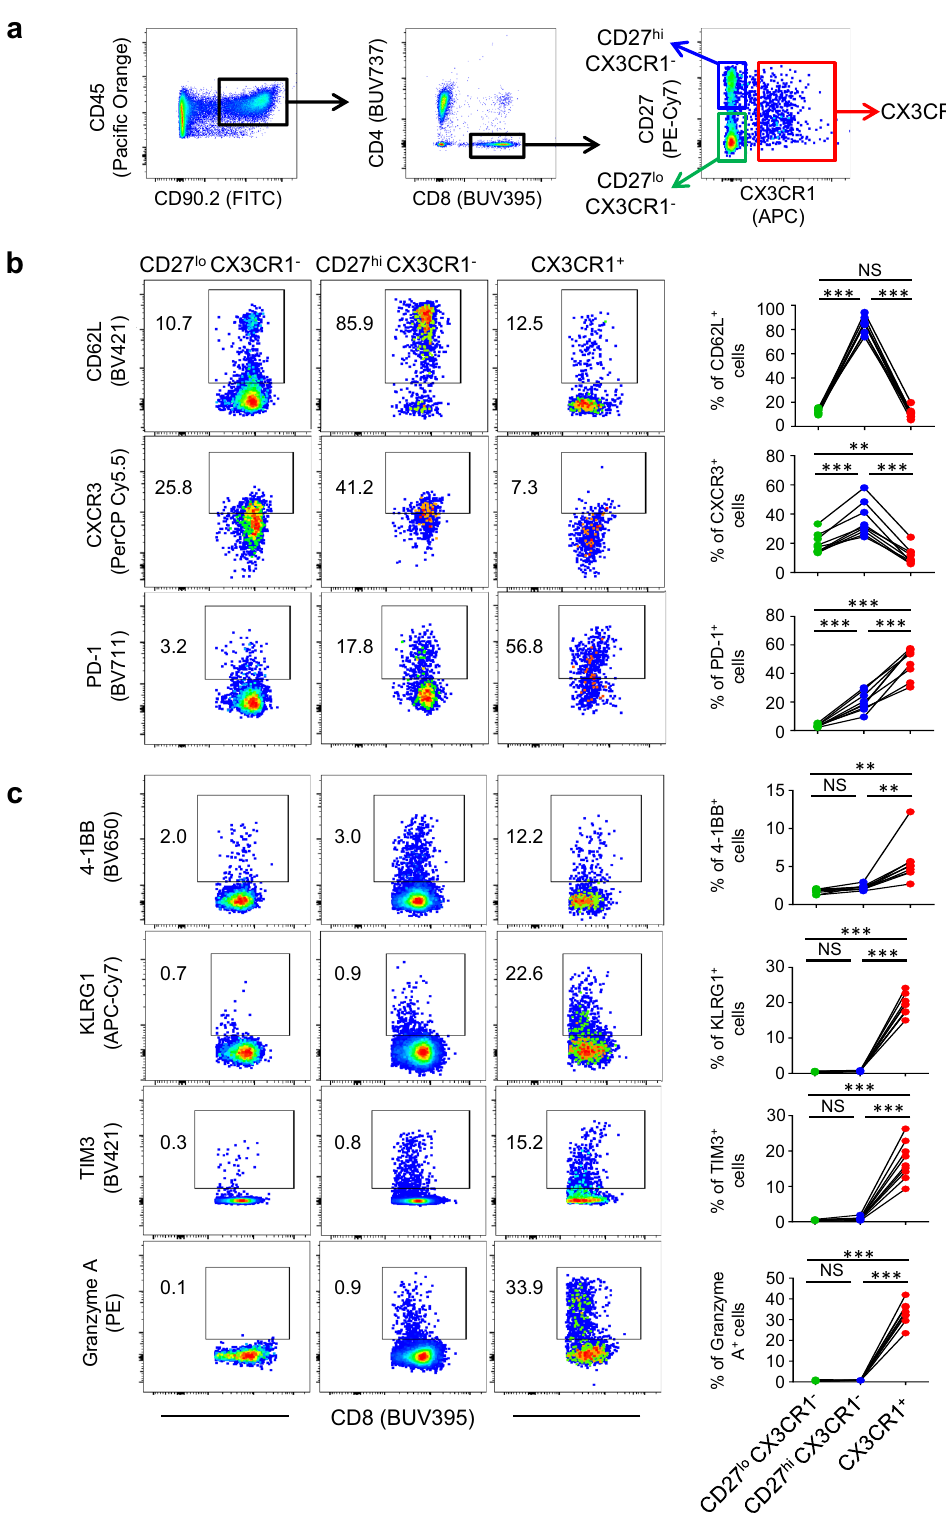
Fig. 2 Phenotypic analysis of peripheral CD8 + T cells in mice treated with immune checkpoint inhibitor (ICI) therapy. a Gating strategy for phenotypic analysis of three subsets (CD27 lo CX3CR1 − , CD27 hi CX3CR1 − , and CX3CR1 + ) of peripheral CD8 + T cells in mice. b , c Mice bearing 10-day established CT26 tumors were treated with anti-PD-L1 antibody (Ab) and anti-CTLA-4 Ab every 3 days and every other day, respectively. Peripheral blood (PB) ( b ) and spleen ( c ) were harvested 2 weeks after initiation of the treatment. Representative fl ow-cytometric plots of three subsets (CD27 lo CX3CR1 − , CD27 hi CX3CR1 − , and CX3CR1 + ) of PB ( b ) and splenic ( c ) CD8 + T cells are shown. Data panels show frequency among CD8 + T cells. NS, not signi fi cant, * P < 0.05, ** P < 0.005, *** P < 0.0001, by one-way repeated measures ANOVA with Tukey ’ s multiple comparisons ( b , c ). n = 9 mice in all groups ( b , c ). Data shown b , c are representative of two independent experiments. Source data are provided as a Source Data fi le.